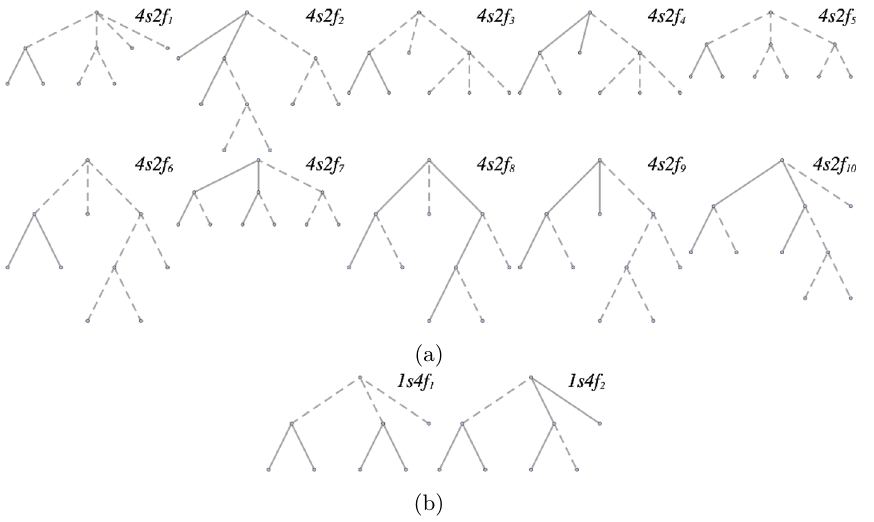
Figure 8. (a) The tree-level topologies relevant for the completions of the four-scalar-two-fermion operator O 0 1 . Only topology 4 s 2 f 3 leads to a novel completion that does not feature a seesaw